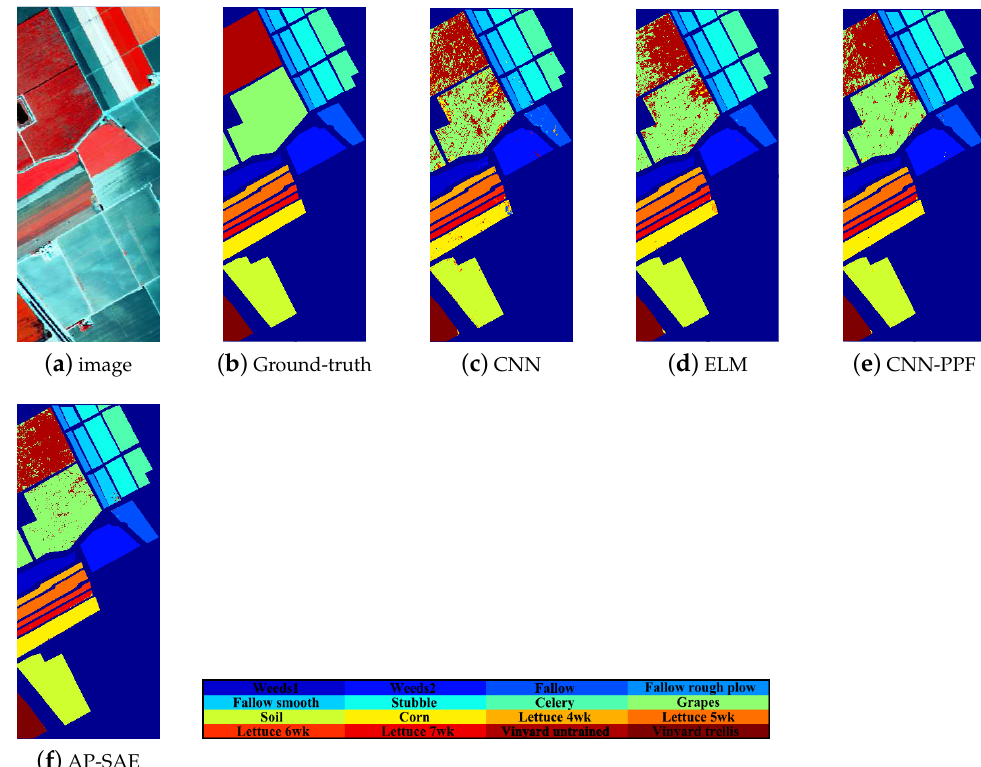
Figure 16. Classification result with 16 classes for the Salinas data set, as thematic